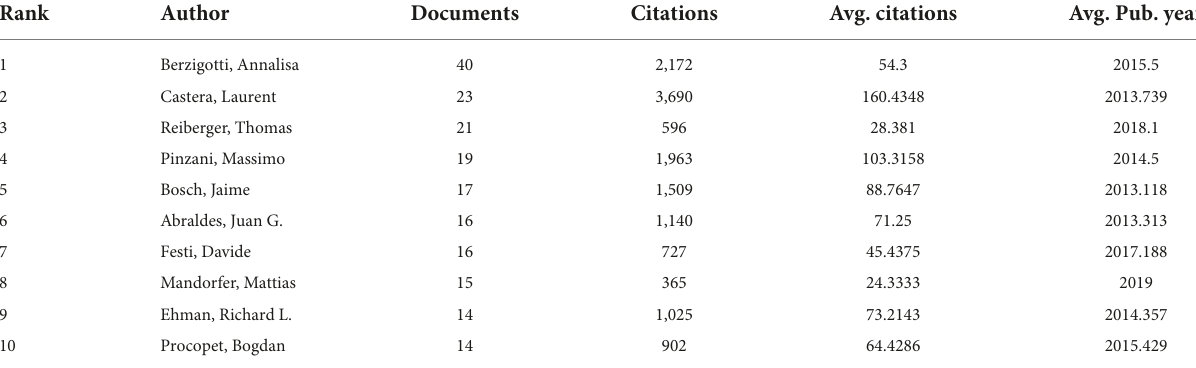
TABLE 4 Top 10 high-yield authors.